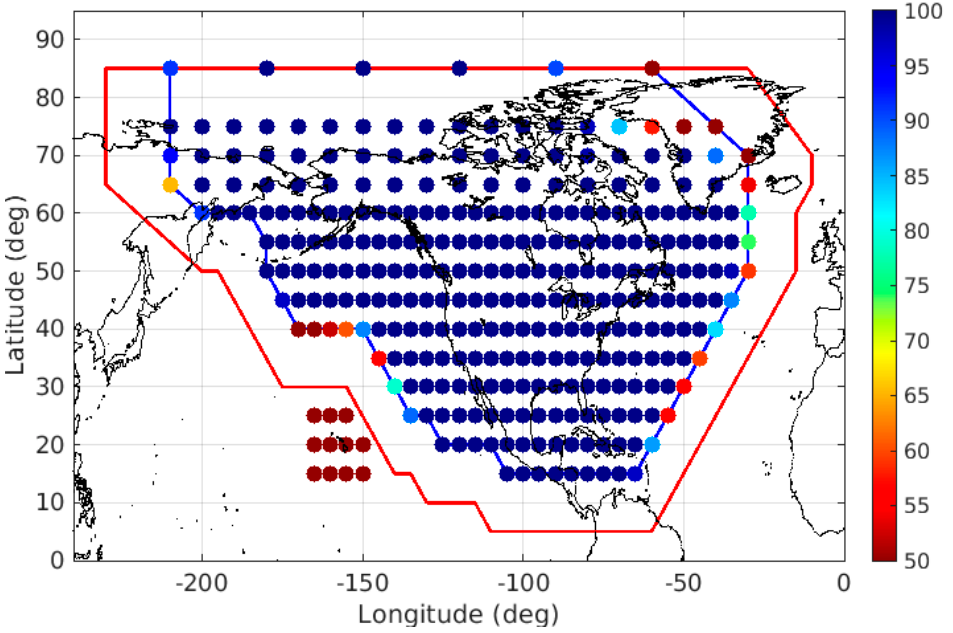
Figure 3. One-month average of WAAS ionosphere correction availability in March 2015.